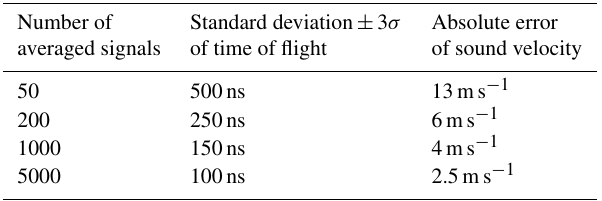
Table 1. Reachable uncertainty.